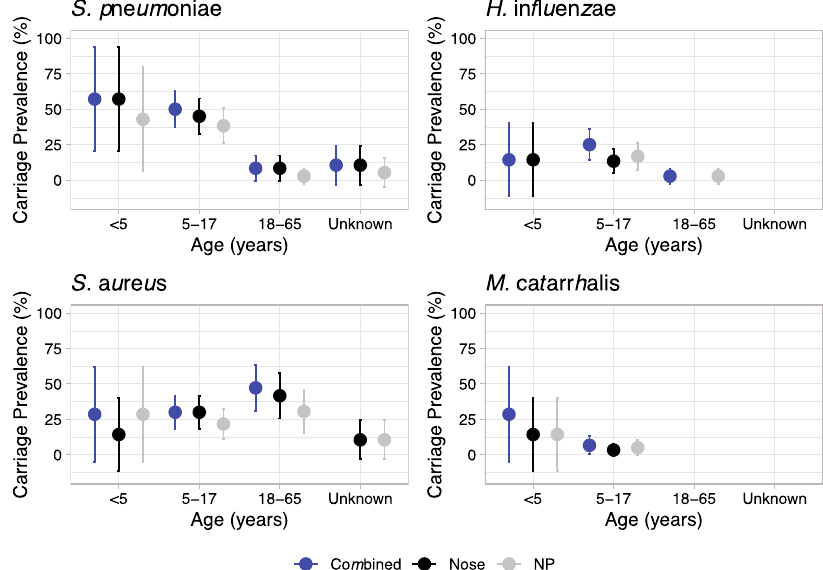
Fig. 2 Carriage prevalence of S. pneumoniae , H. in fl uenzae , S. aureus and M. catarrhalis . Point estimates for percentage carriage prevalence of four key upper respiratory tract pathobionts are shown across three age groups <5, 5 to 17 and 18 to 65. Those aged 65 + are not shown due to limited numbers. All ‘ Unknowns ” were of adult age. Carriage was estimated overall i.e. a positive swab culture from either nasal or nasopharyngeal swab (dark blue), and also separately for each swab type (nasal — black; NP — grey). Error bars show 95% CI intervals.